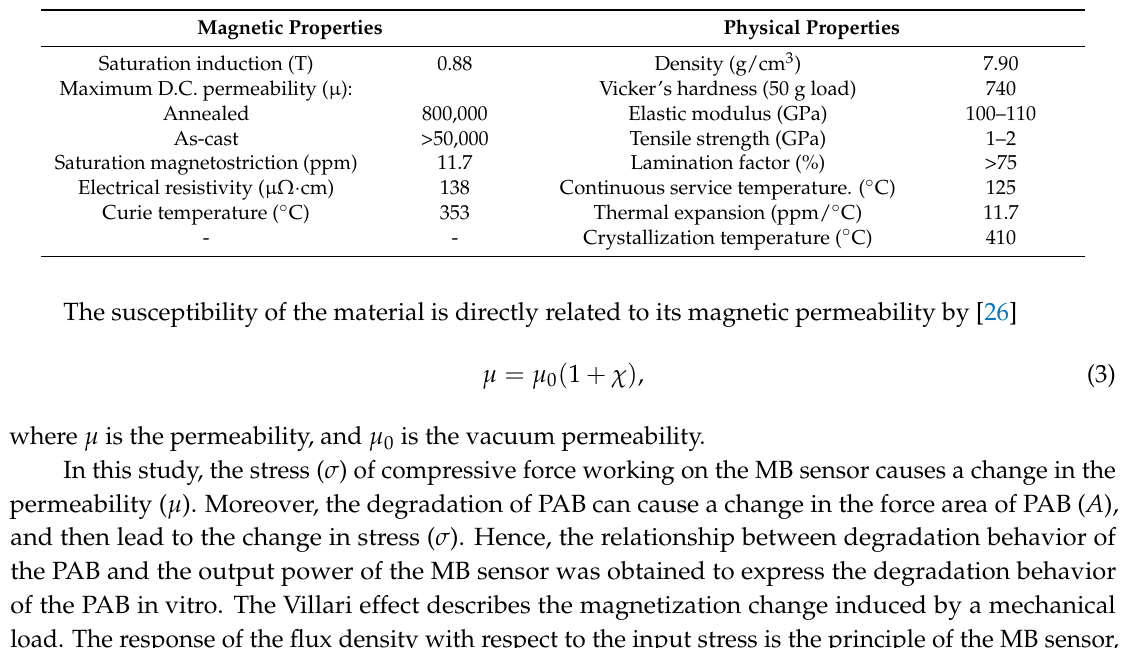
Table 1. The magnetic and physical properties of magnetoelastic material.